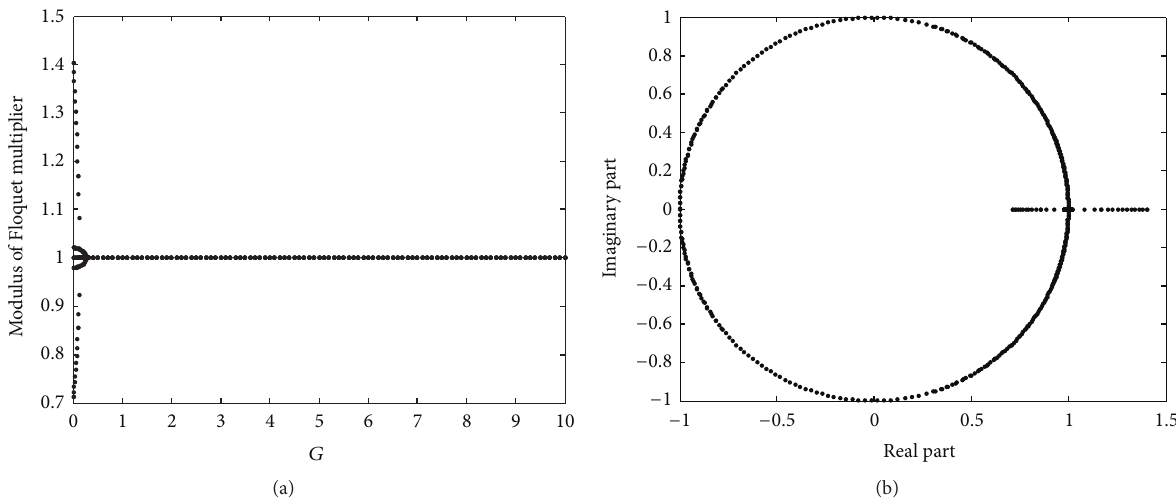
Figure 5: Floquet multipliers of the Periodic Hamiltonian System: (a) the relationship between the moduli of Floquet multipliers and the controller gain 𝐺 ; (b) the Floquet multipliers and the unit circle in the complex plane.